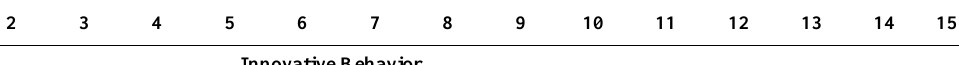
Table 1. The descriptive and correlational analysis results